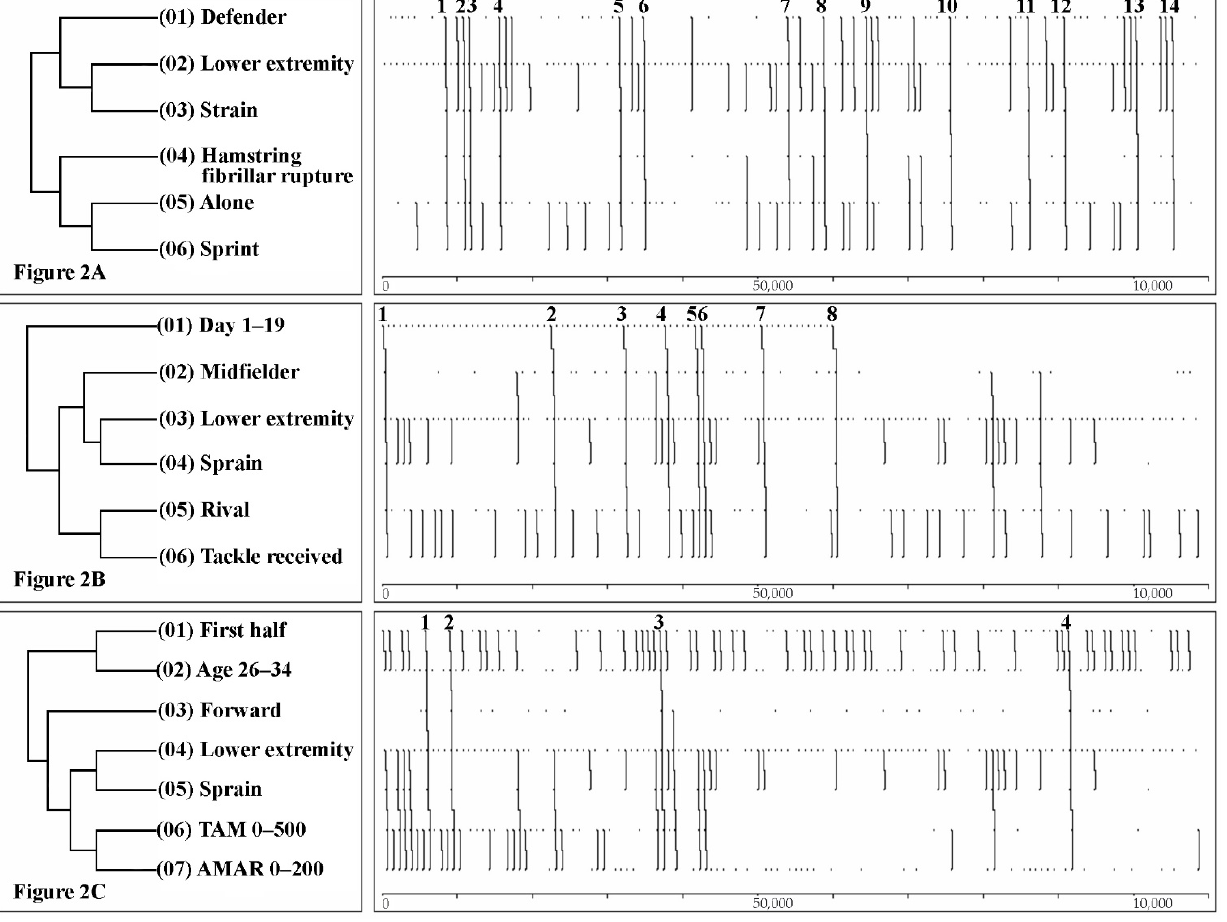
Figure 2. T-patterns of the investigation: ( A ) defender, ( B ) midfielder and ( C )